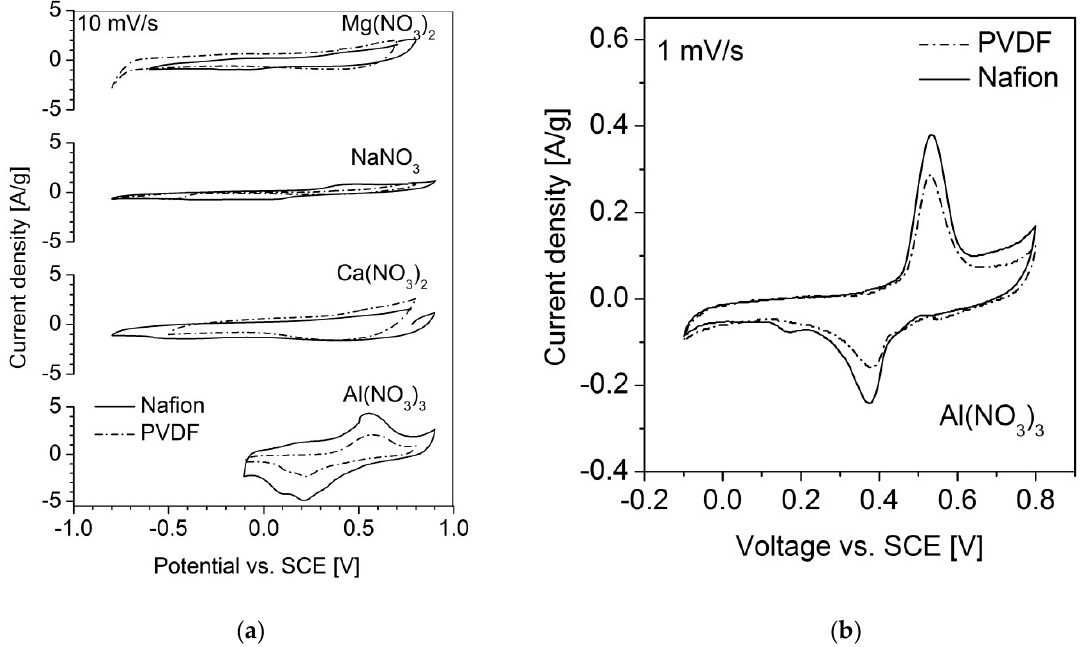
Figure 6. ( a ) Cyclic voltammograms of the composite electrode comprising VOPO 4 · 2H 2 O, carbon black, and a binder (PVDF or Nafion) in NaNO 3 -, Ca(NO 3 ) 2 -, Mg(NO 3 ) 2 -, and Al(NO 3 ) 3 -saturated aqueous solutions at scan rate of 10 mVs − 1 . ( b ) Cyclic voltammograms of the composite electrode comprising VOPO 4 · 2H 2 O, carbon black, and a binder (PVDF or Nafion) in Al(NO 3 ) 3 -saturated aqueous solution at scan rate of 1 mVs − 1